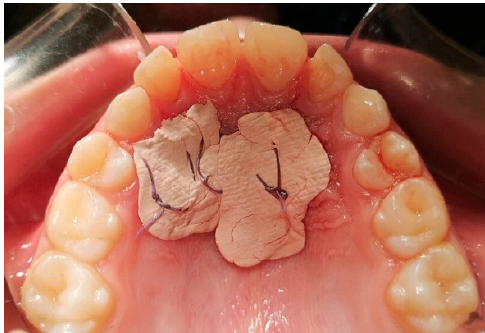
Figure 5. Periodontal dressing.